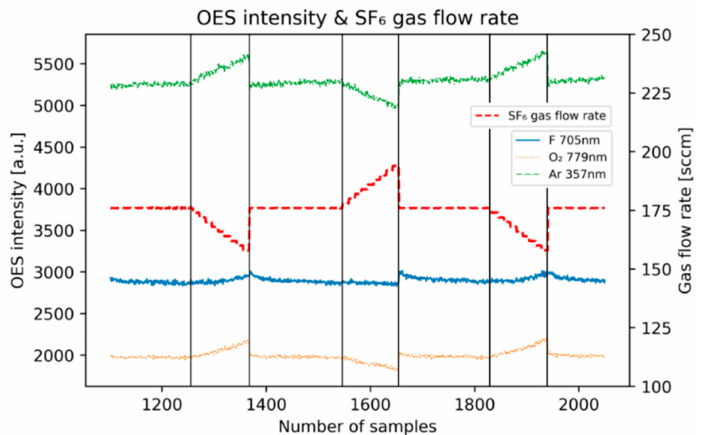
Figure 6. Change of optical emission spectroscopy (OES) intensity and SF 6 gas flow rate according to the faulty process